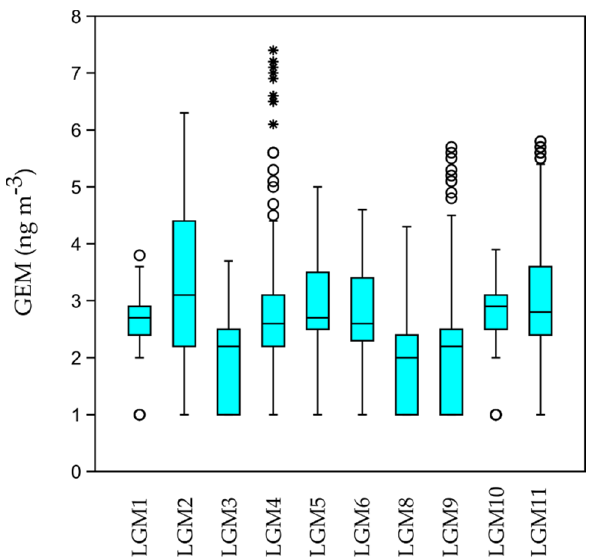
Figure 2. Boxplots of GEM measured in the investigated sites.